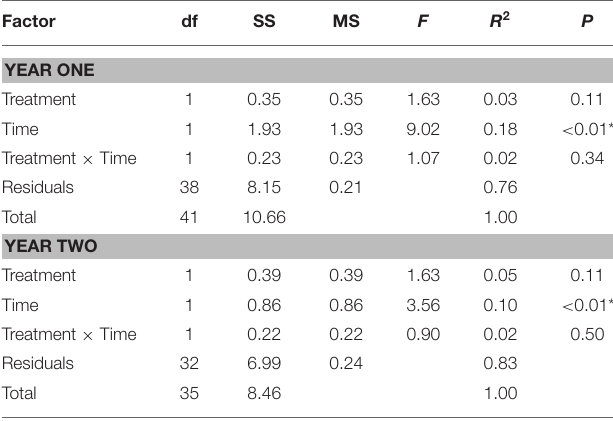
TABLE 1 | PERMANOVA results testing benthic macroinvertebrate community structure based on Bray-Curtis distances for each year of the study with significant results ( p < 0.05) indicated by an